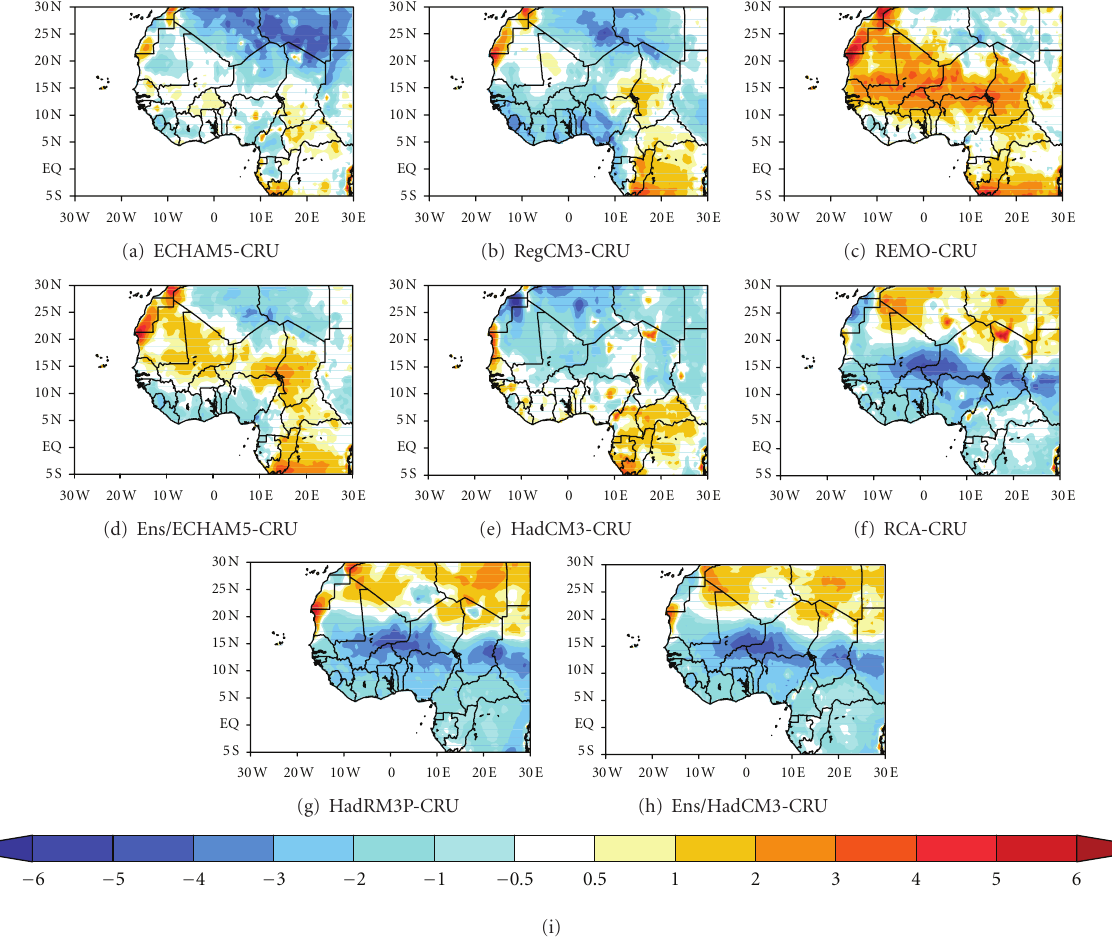
Figure 3: 1981–2000 averaged JJAS bias of temperature (in ◦ C) for (a) ECHAM5, (b) RegCM3, (c) REMO, (d) Ens/ECHAM5 (ensemble mean of RCMs driven by ECHAM5), (e) HadCM3, (f) RCA, (g) HadRM3P, and (h) Ens/HadCM3 (ensemble mean of RCMs driven by HadCM3) compared with CRU.